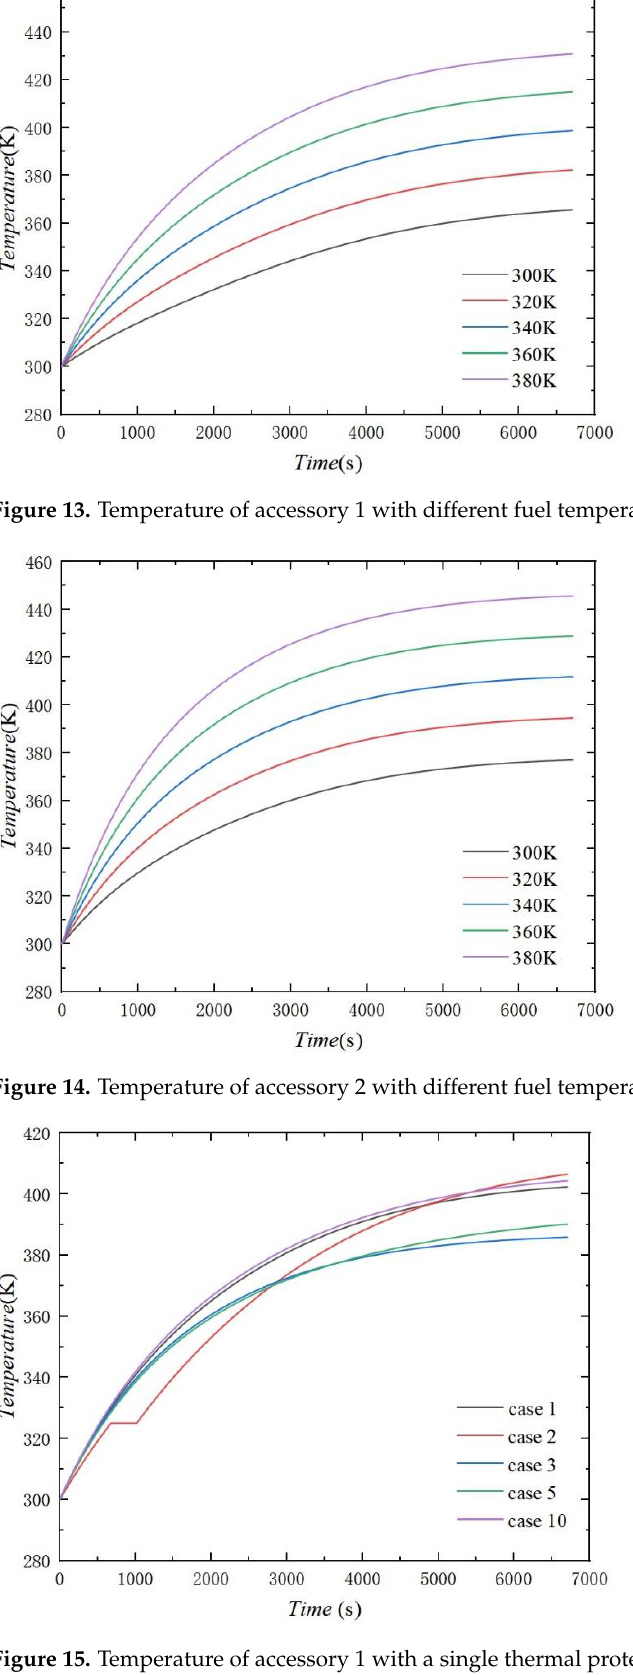
Figure 16. Temperature of accessory 2 with a single thermal protection measure. For the turbine engine’s accessory 1 with internal fuel access and an internal heat source, the effects of case 3 (ventilation cooling) and case 5 (adding heat insulation layer